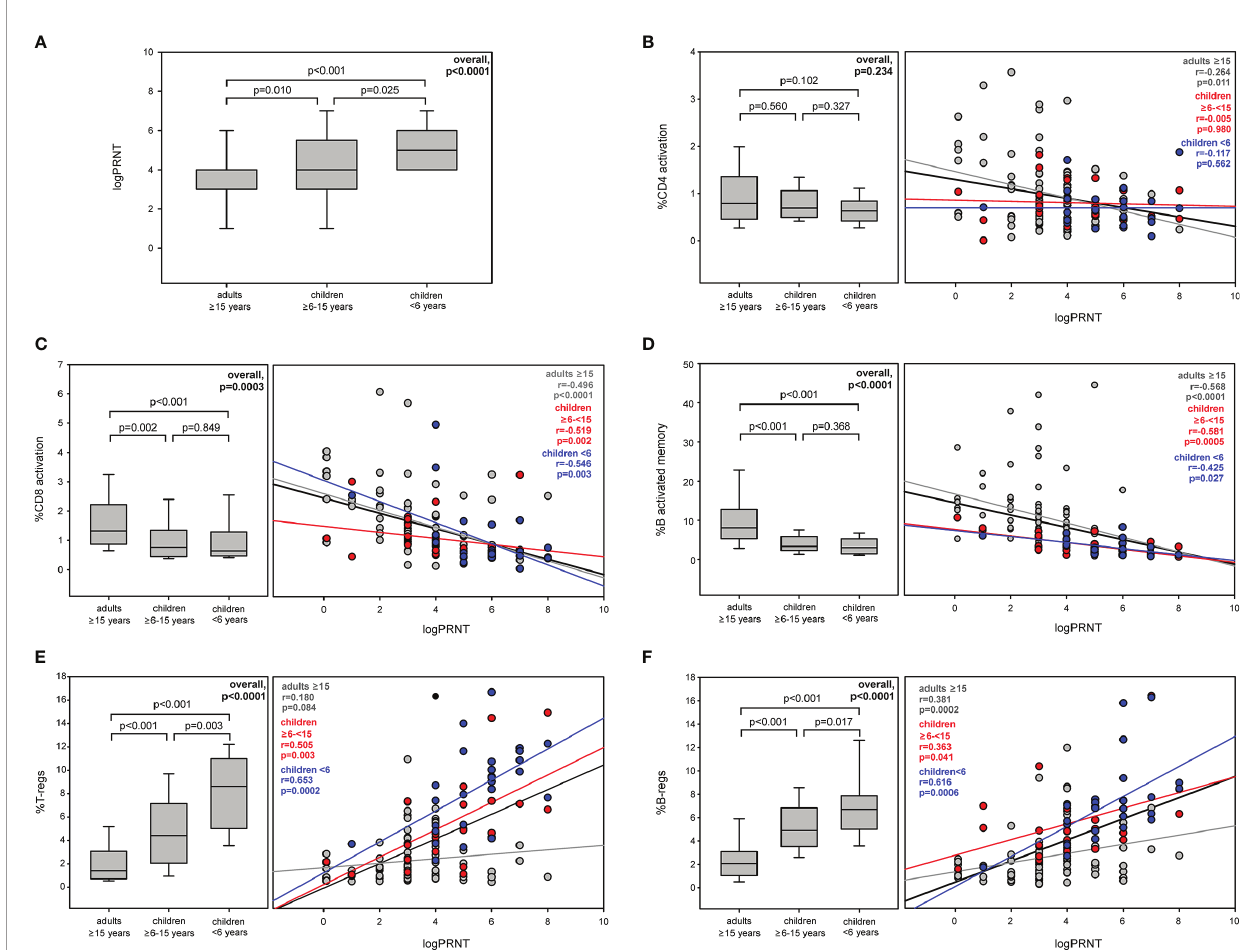
FIGURE 1 | Levels and relationship between immune activation and Tregs and Bregs with PRNT at fi rst sampling Levels of PRNT (A) , activated CD4 (B) , activated CD8 (C) and activated memory B cells (D) , Tregs (E) , and Bregs (F) in COVID-19 subjects among age classes and the relationship of these immunological markers with PRNT values at 2.8 (2.1 – 3.7) months after